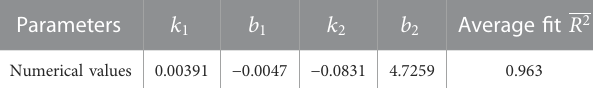
TABLE 3 Fitting parameters of exponential function type I.